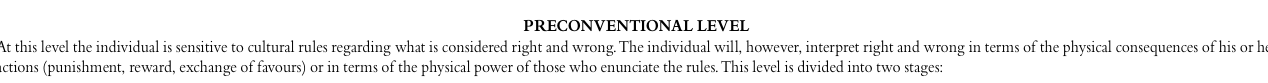
TABLE1 LEVELSANDSTAGESOF MORALREASONINGACCORDINGTO